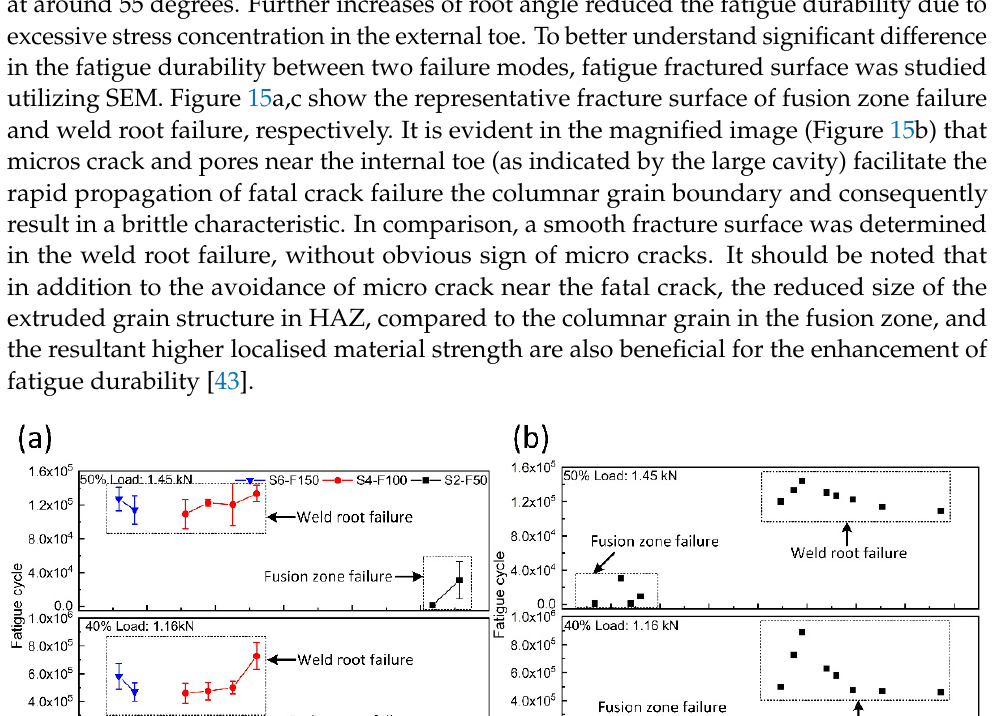
Figure 15. Representative fatigue fractography of ( a ) the fusion zone failure and ( c ) the weld root failure, with detailed views in ( b ) and ( d ). 4. Conclusions This paper investigated the impact of transverse micro solidification cracks in remote laser welding of AA6063-T6 fillet lap joint at different welding speeds with consideration to part-to-part bonding, laser beam oscillation and power modulation. Results show that: (1) Transverse micro cracks occur along the columnar grain boundaries near fusion lines. Increasing welding speed from 2 m/min to 6 m/min, simultaneously with an increas- ing laser power for the purpose of good part-to-part gap bridging, did not show any risk of introducing additional transverse micro cracks.